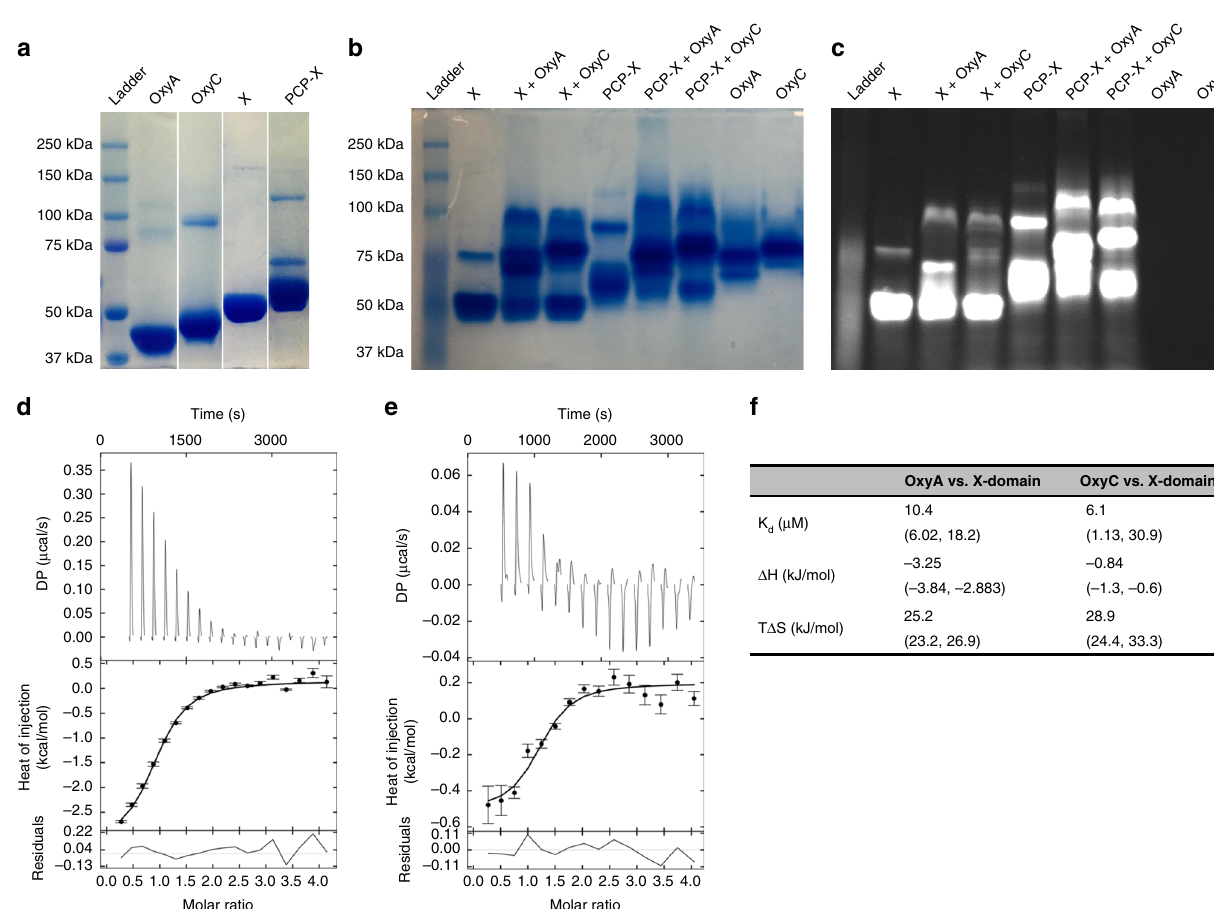
Fig. 4 Interaction of OxyA kis and OxyC kis with the X-domain from the kistamicin NRPS. a SDS-PAGE of OxyA kis (44.9 kDa), OxyC kis (48.8 kDa), the X kis - domain (52.0 kDa) and PCP-X kis (60.2 kDa). Native PAGE of the X kis -domain and PCP-X kis didomain in isolation and after co-incubation with OxyA kis and OxyC kis visualised both with Coomassie blue stain ( b ) and using UV visualisation ( c , following prior FITC labelling of the X kis -domain and the PCP-X kis didomain). d Representative ITC isotherm data for interactions between ( d ) OxyA kis and ( e ) OxyC kis with the X kis -domain. The upper panels represent baseline-corrected power traces; by convention, negative power corresponds to exothermic binding. The middle panels represent the integrated heat data fi tted to the single binding sites model in SEDPHAT 58 , with fi gures produced using GUSSI 59 . The bottom panels show the residues of the fi t with error bars are standard error in the integration of the peaks as calculated by NITPIC ( n = 1) 57 . f Binding af fi nities of OxyA kis and OxyC kis with the X kis -domain. Af fi nities were determined by ITC at 25 °C with stirring at 300 rpm. 68.3% con fi dence intervals (1 Std. Dev.) are given in parentheses for K a and K d as calculated from a single titration. Source data are provided as a Source Data fi